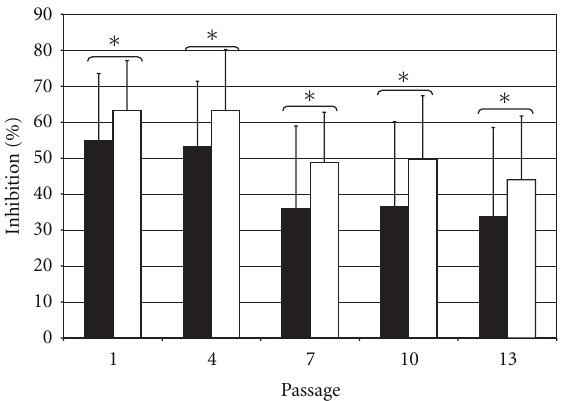
Figure 4: E ff ect of PBMC and IL-1 β stimulation on the immuno- suppressive activity of hMSCs. Immunosuppressive activity (mean ± standard deviation; n = 10; 5 control and 5 FGF-treated) of medium conditioned by MSCs from di ff erent passages stimulated with PBMCs (black bars) or IL-1 β (white bars). Values are expressed as percent inhibition relative to the internal controls. Higher bars indicate higher immunosuppressive activity. Asterisks indicate significant di ff erences in one-tail paired t -test; ∗ P < . 05.